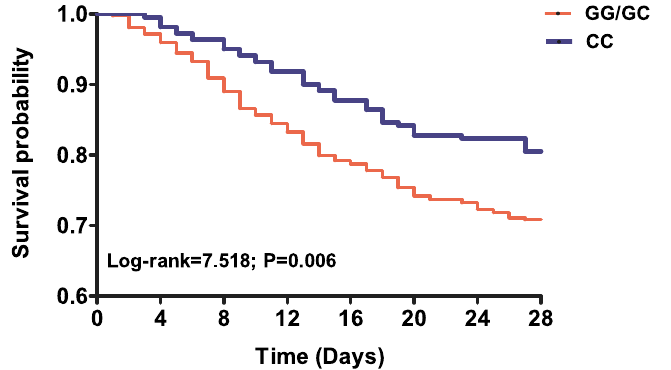
Figure 1. Kaplan–Meier survival analysis of septic patients. The influence of NLRP3 29940G>C polymorphism on the 28-day survival of patients with sepsis was evaluated via using the Kaplan–Meier survival analysis.